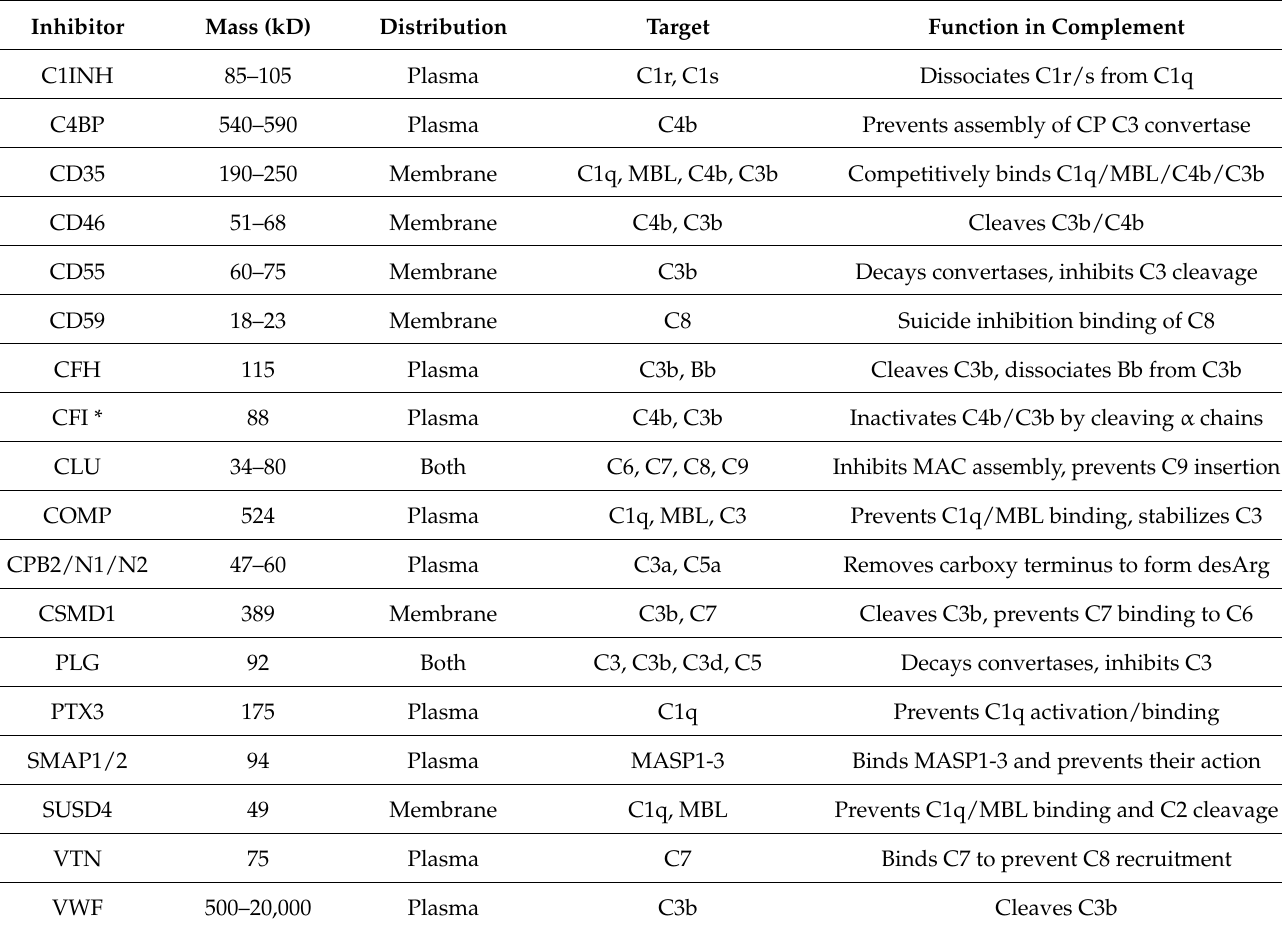
Table 1. Functions of complement inhibitors expressed by